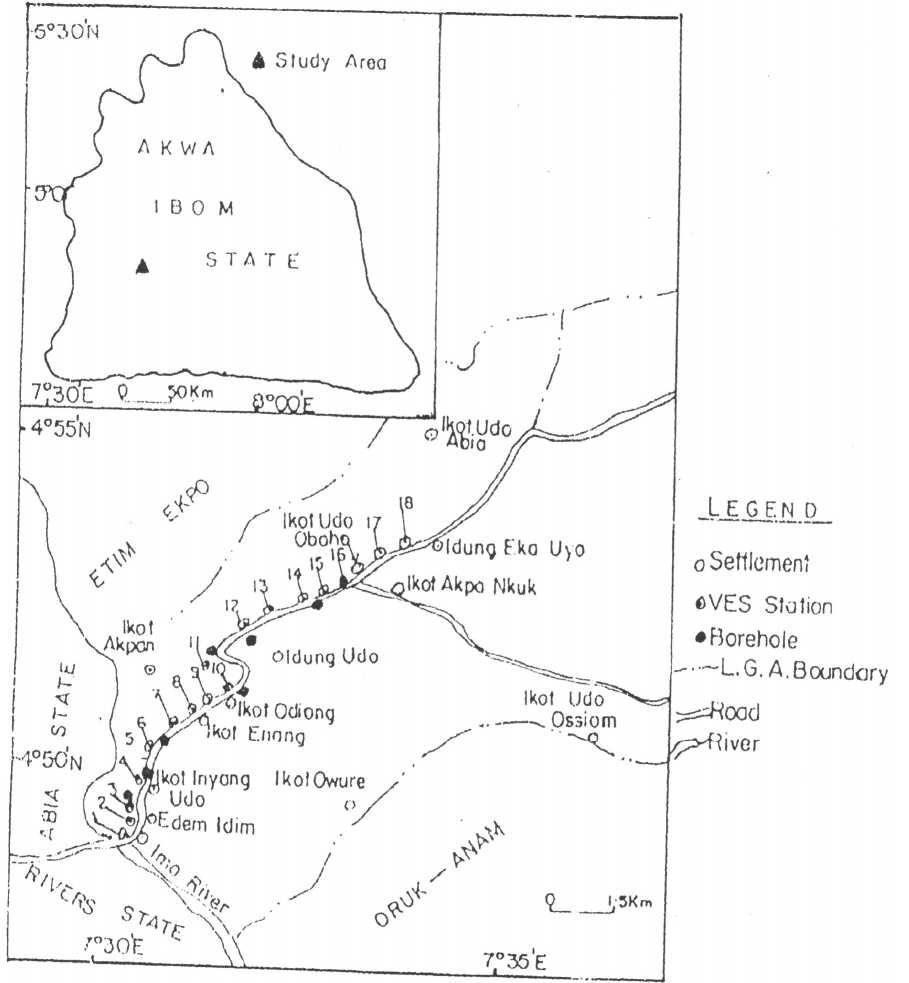
Figure 1. Location map of southern Ukanafun local government area of Akwa Ibom State showing VES and boreholes